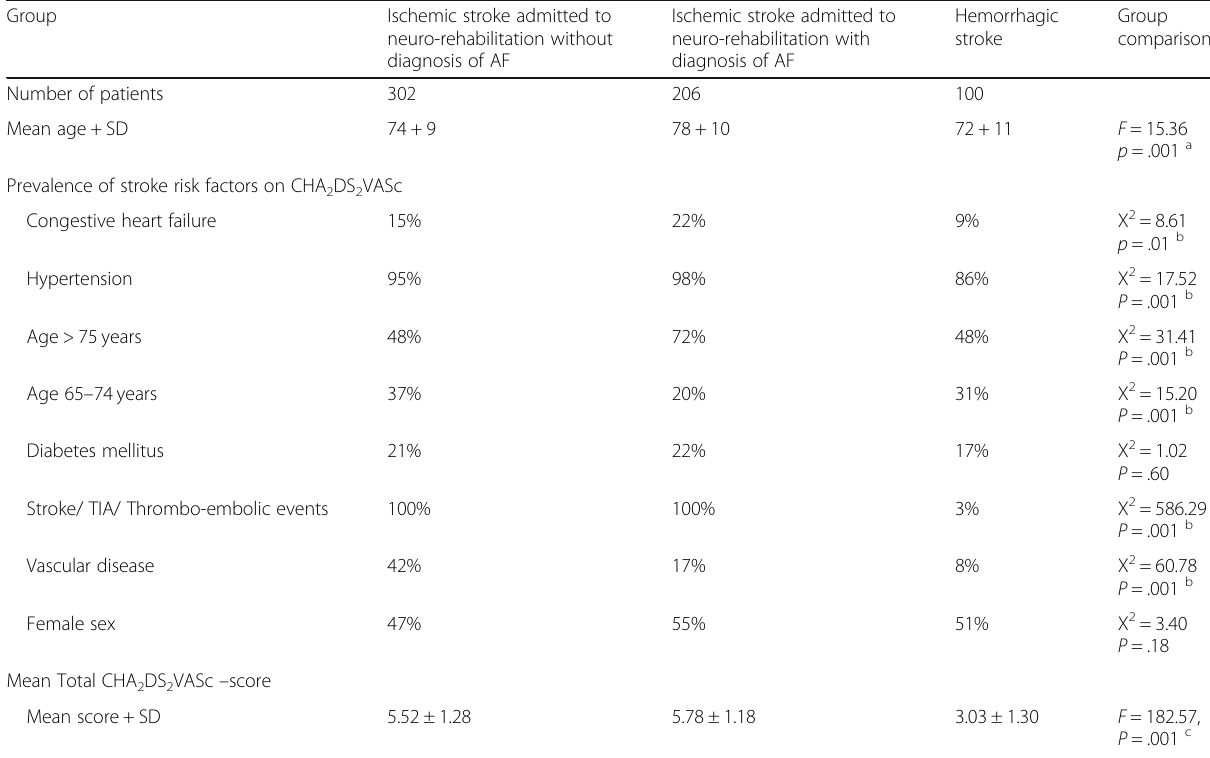
Table 1 Patient characteristics including mean CHA 2 DS 2 VASc -score Group Ischemic stroke admitted to neuro-rehabilitation